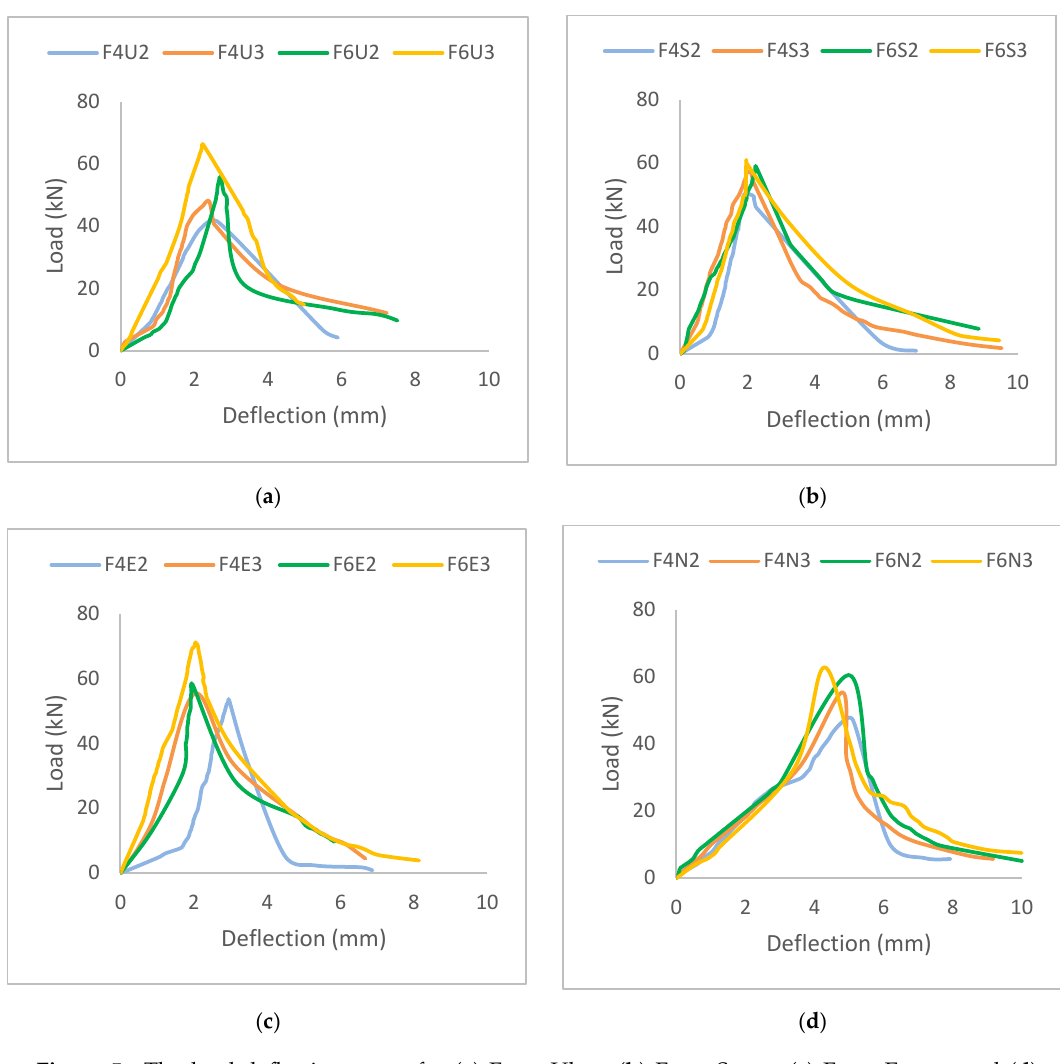
Figure 5. The load-deflection curve for ( a ) Ferro-Ultra, ( b ) Ferro-Super, ( c ) Ferro-Econo, and ( d ) Ferro-Nylo hybrids under direct shear.